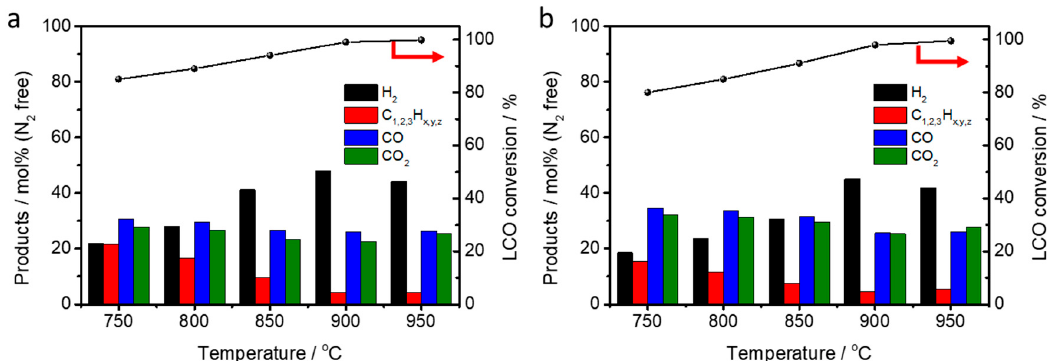
Figure 5. Reformate (H 2 , CO, CO 2 , and C 1,2,3 H n ) productions (mol%) from LCO-ATR tests under the temperature range of 750–950 °C (H 2 O/O 2 /C = 1.5/0.4/1, GHSV = 4000 h − 1 ) for ( a ) LaCo 0.85 Ru 0.15 O 3 and ( b ) LaCr 0.85 Ru 0.15 O 3 catalysts.